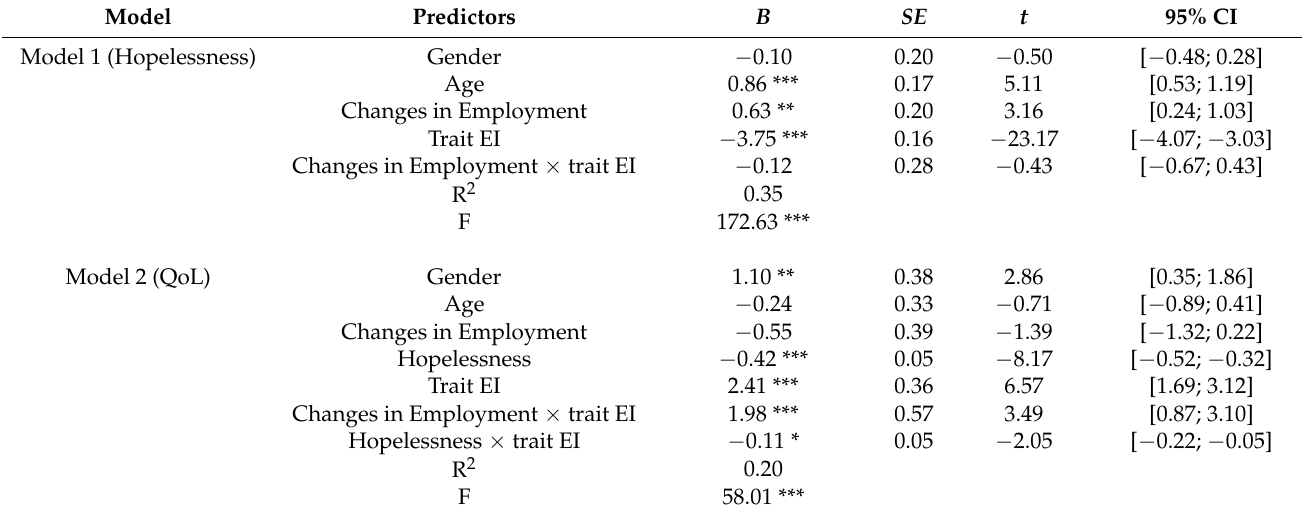
Table 2. Testing the moderated mediation effects of changes in employment on quality of life during the COVID-19